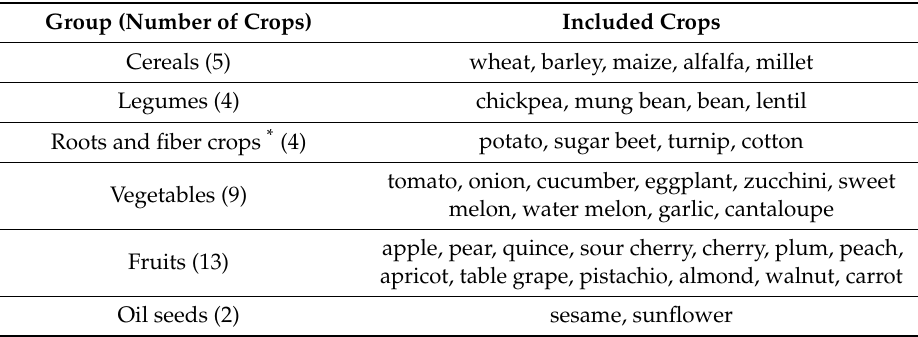
Table 2. Classifying the different crops used in this research ( * hereafter only “fiber crops” is used). Group (Number of Crops)